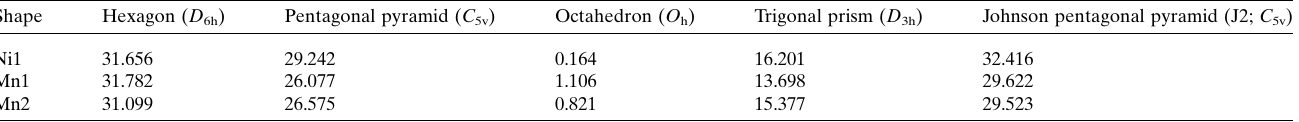
Table 2 Continuous Shapes Measures (CShM) values for the geometry about the six-coordinate central Ni II and ring Mn III ions of 1 . Shape Hexagon ( D 6h )